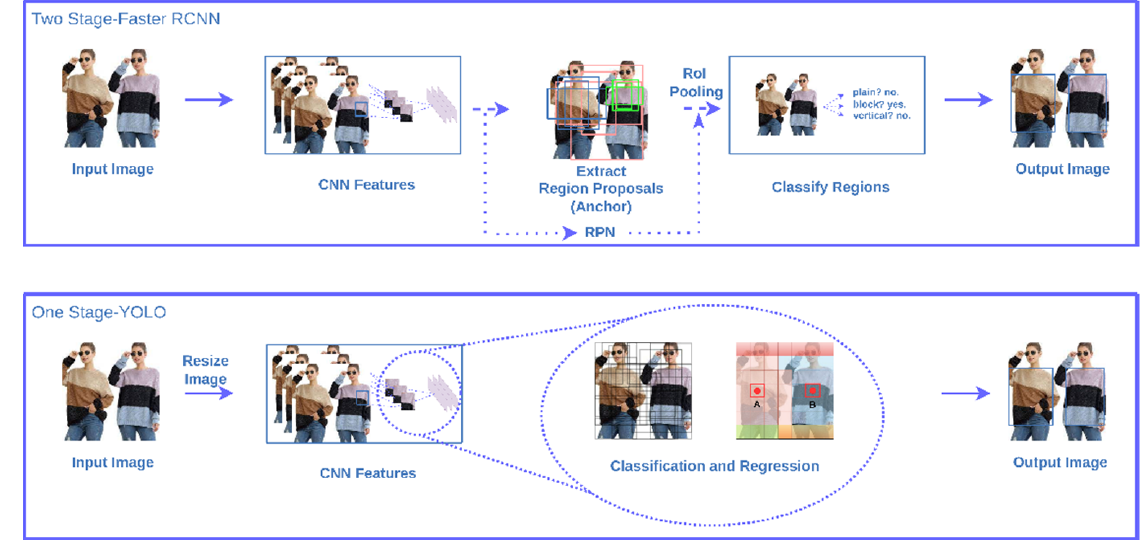
Figure 2. Comparison between one-stage and two-stage object detection algorithms.